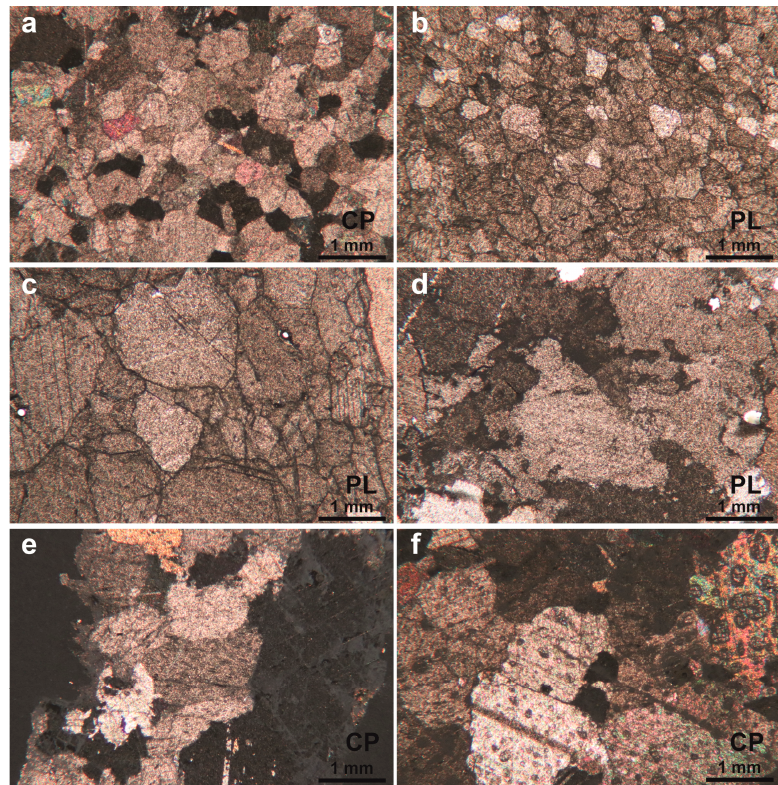
Figure 3. Selection of photomicrographs: ( a ) MU.7776, Carrara; ( b ) MU-SN, Carrara; ( c ) MU.8461, probable local quarry; ( d ) MA2018.7740-1, probable local quarry; ( e ) MA2018.7724-9, probable local quarry; ( f ) MA2018.7742; probable local quarry. CP—cross polarized light; PL—plane polarized light.